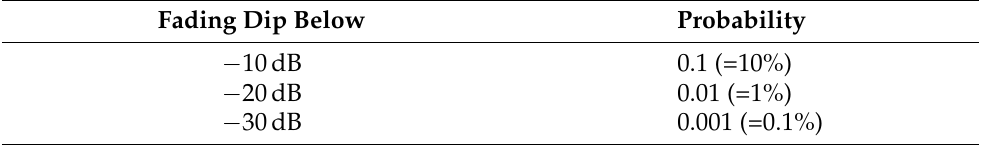
Table 1. Probability of fading in a Rayleigh